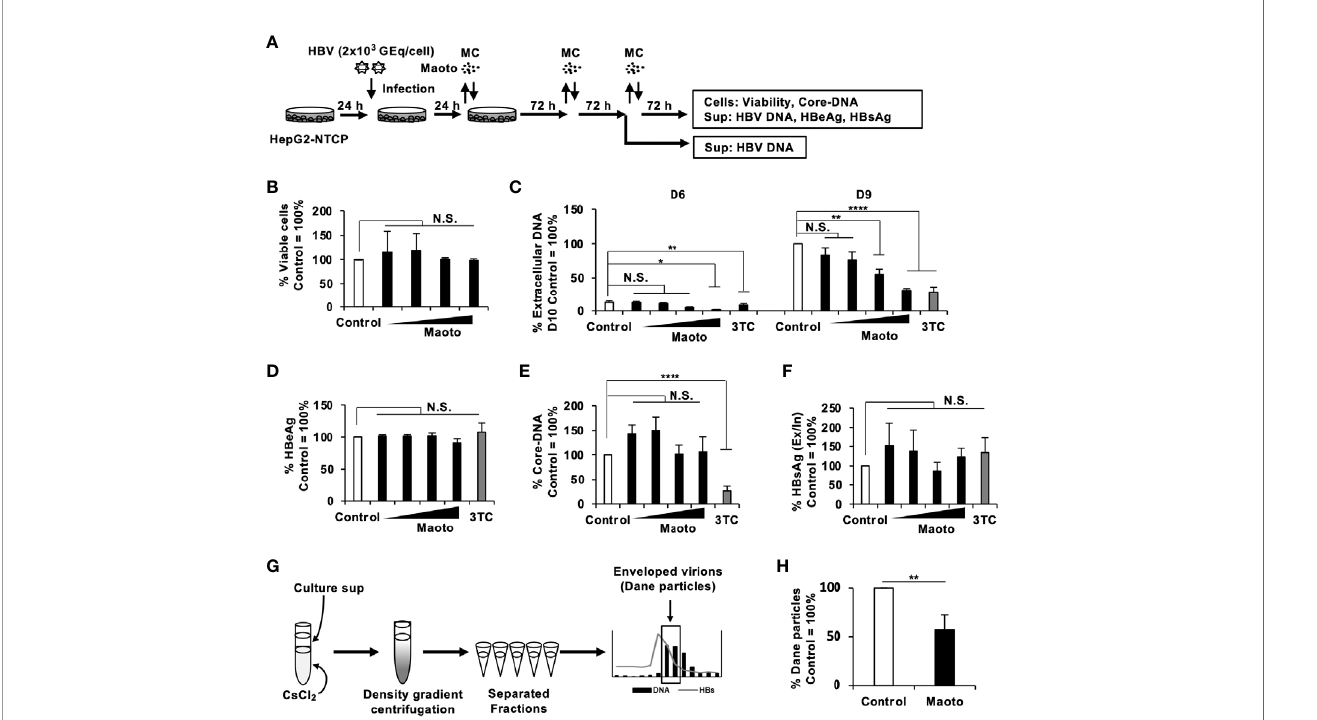
FIGURE 3 | Maoto inhibits hepatitis B virus (HBV) production by interfering with HBV nucleocapsid incorporation into viral particles in HepG2-NTCP cells. (A) Schematic representation of the protocol of maoto treatment and HBV infection in HepG2-NTCP cells. Cells were infected with HBV and then treated with distilled water (control) or concentrations of 1.5625, 6.25, 25, and 100 µg/ml of maoto extract for 9 days with refreshing the medium and Kampo (MC) every 3 days. (B) Viability of HepG2-NTCP cells. Cells were treated with concentrations of 1.5625, 6.25, 25, and 100 µg/ml of maoto extract for 9 days. Viability was determined after 9 days of treatment using the CellTiter-Glo assay. (C) Extracellular HBV DNA. HBV DNA in culture supernatants of the cells after 6 and 9 days of maoto treatment was measured by real-time PCR. (D) Extracellular HBeAg. HBeAg in culture supernatants of the cells after 9 days of maoto treatment was determined by ELISA. (E) Core-DNA. Core-DNA was extracted from the cells after 9 days of maoto treatment and measured by real-time PCR. (F) The Ex/In HBsAg ratio. Extracellular and intracellular HBsAg after 9 days of maoto treatment was determined by enzyme-linked immunosorbent assay (ELISA), and the ratio was calculated by dividing extracellular HBsAg with intracellular HBsAg. (G) Schematic representation of the protocol of Dane particle puri fi cation. The fractions containing both HBV DNA and HBsAg were considered enveloped virion (Dane particles). (H) Effect of maoto on Dane particle production. The amount of Dane particles was determined by measuring HBV DNA with real-time PCR. Lamivudine (1 µM, 3TC) was used as a positive control for the inhibition of HBV production. Values are expressed as the mean percentage + S.E. of three or four independent experiments. * P < 0.05; ** P < 0.01; **** P < 0.001; N.S., no signi fi